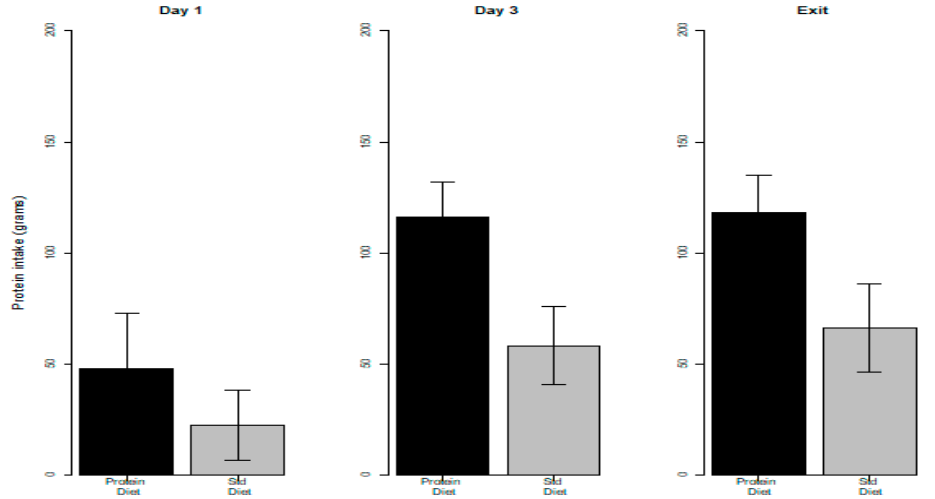
Figure 2. Protein intake in the intervention and control groups on day 1, 3, and study exit.